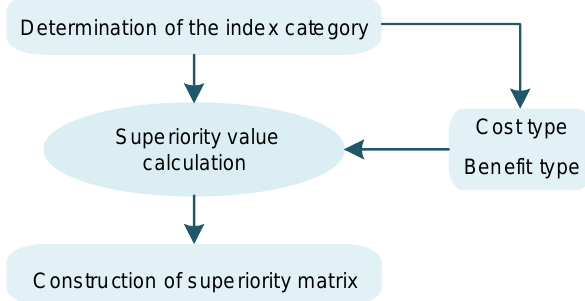
Figure 3. Flow chart of superiority matrix construction.